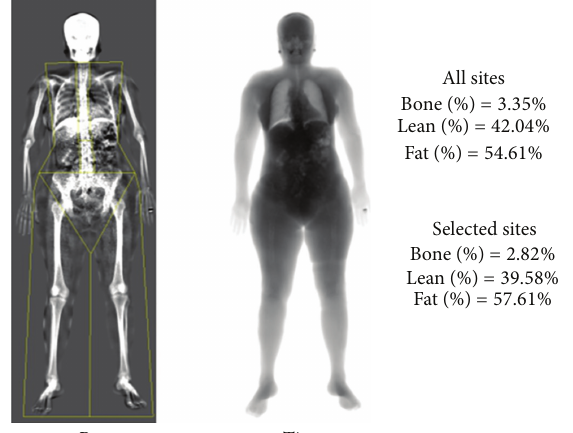
Figure 1: Body mass composition result, indicating the bone tissue percent with regard to body mass (Lexxos C05LX223 software v6.0551).